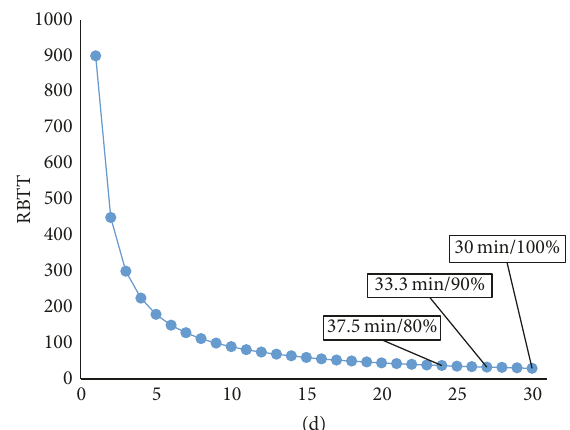
Figure 3: Result of RBTT with different TR in 30 workdays.